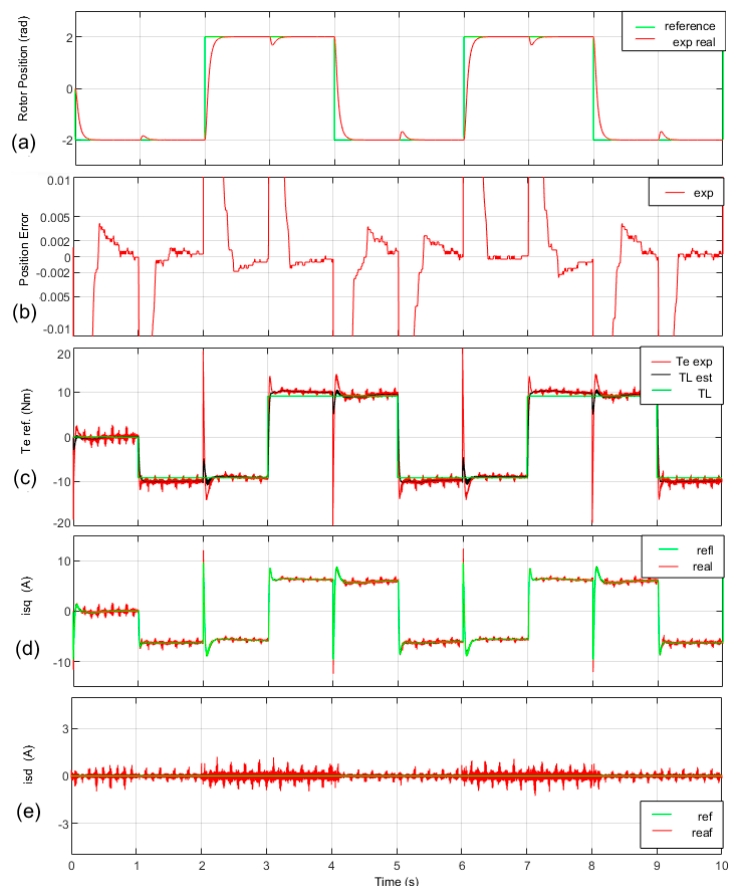
Figure 10. Experimental test employing the D2 design for the IM machine: ( a ) rotor position, reference and real (rad); ( b ) rotor position error (rad); ( c ) rotor position error zoom (rad); ( d ) electromagnetic torque (Te), estimated load torque (TL est) and load torque (TL), (N · m); ( e ) torque current, isq (A) and ( f ) rotor flux current, reference and real, isd (A)